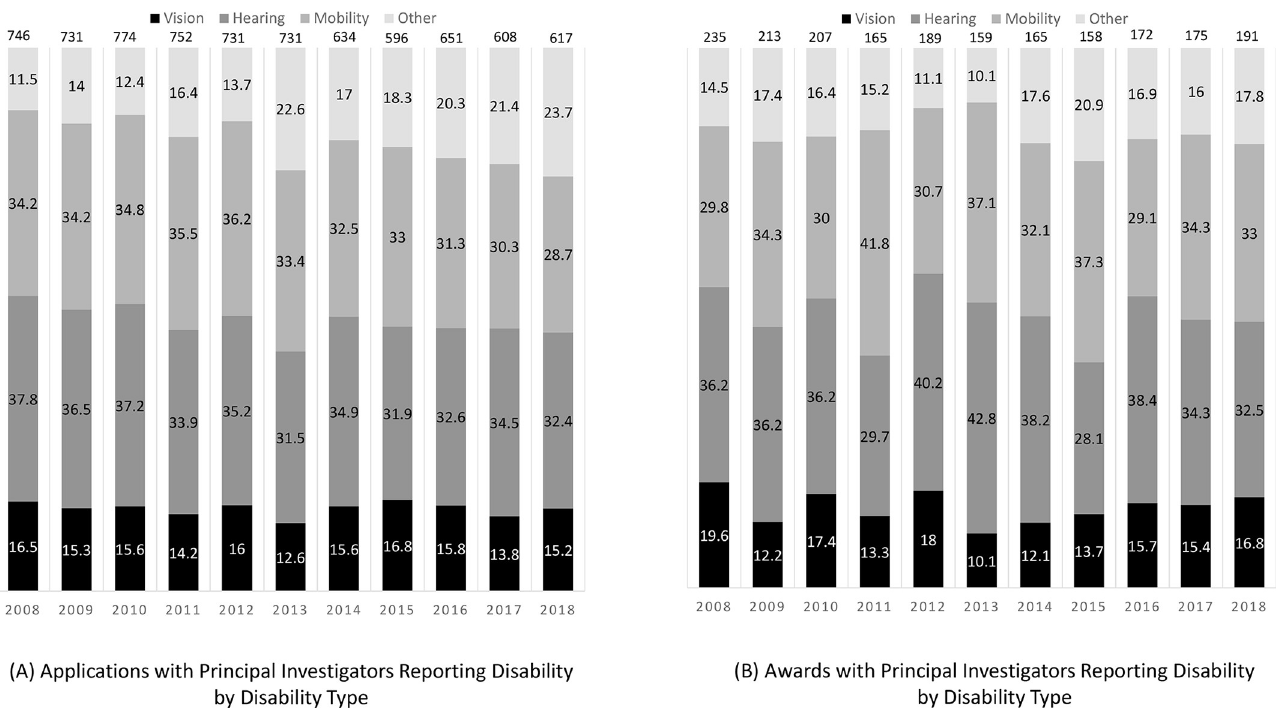
Reporting Disability by Disability